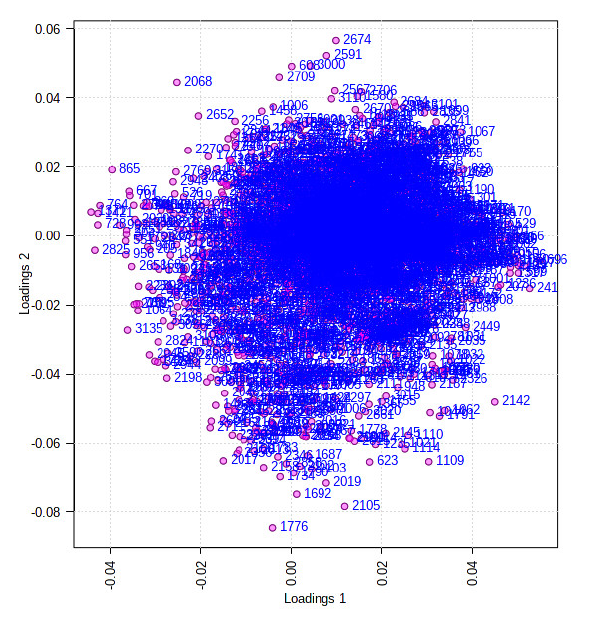
Figure 4. PCA loading plot in unsupervised analysis obtained from DFC and DFS. Shown data are the Var ID (peak number).